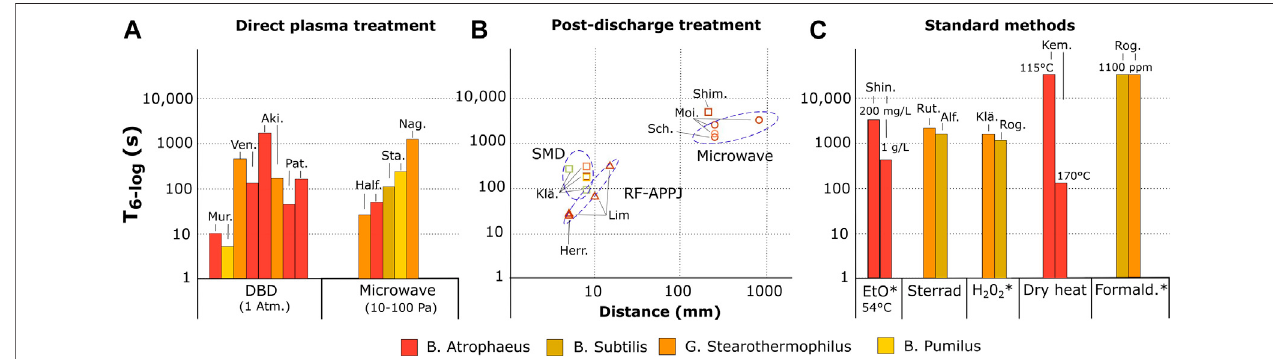
FIGURE5| ExposuretimeT 6log requiredtoachieveatleasta6-logreductionofvarioustypesofsporesondriedsurfaceusingdifferentmethods. (A) directplasma exposure with DBD (Mur. [26, 49], Ven. [44], Aki. [45], Pat [38]) microwave plasma (Half. [27], Sta. [50], Nag [51]) (B) post-discharge exposure as a function of the distance between the plasma and the treated sample using SMD ( □ , Klä. [25, 52], Shim [53]), RF-APPJ ( Δ , Lim [54], Herr [55]) and microwave plasma ( ○ , Sch. [56], Moi [57]). (C) standarddecontaminationmethodsincludingethyleneoxide(EtO,Shin[58]),Sterradsystems(Rut.[59],Alf[24]),hydrogenperoxide(H Supplementary material and in the mentioned references. Theasterisk indicates thatthe technique requires an additional aeration time (typically 15 h)in order to remove toxic